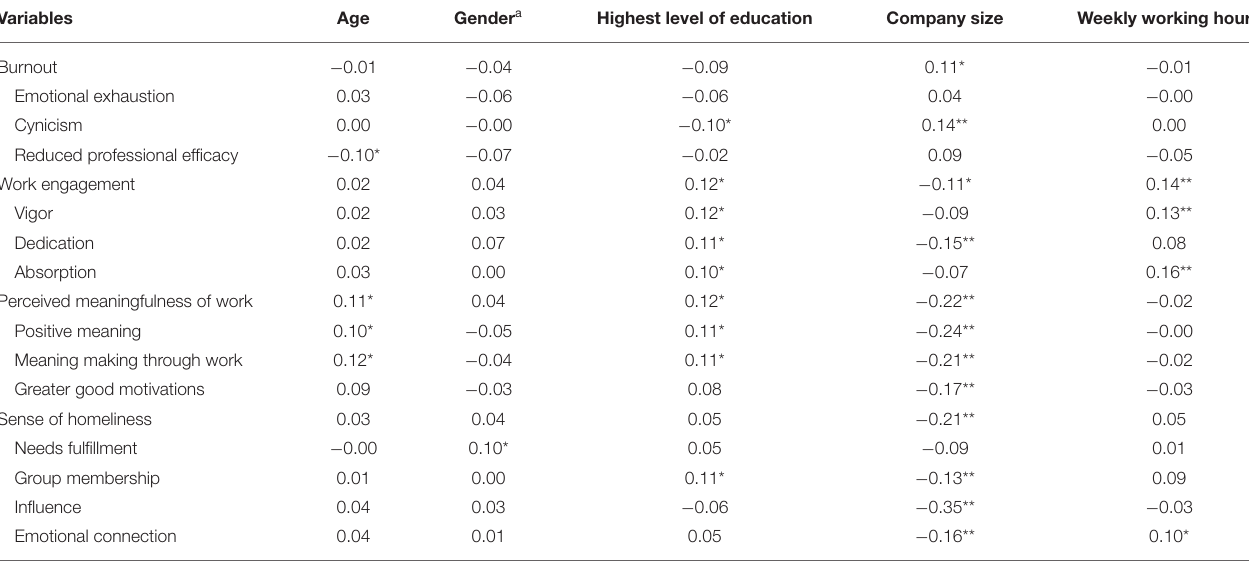
TABLE 4 | Correlations of selected socio-demographic and work-related variables with study variables. Variables